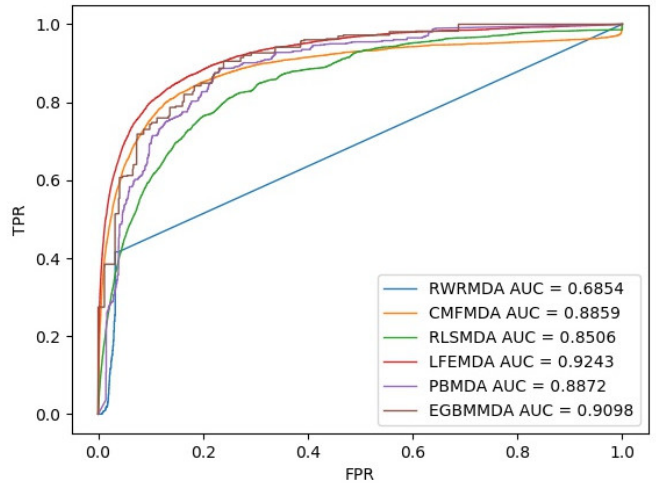
Figure 1. Performance comparison between LFEMDA and the other three models (RWRMDA, CMFMDA, RLSMDA, PBMDA and EGBMMDA) in terms of ROC curve and AUC based on LOOCV, respectively.